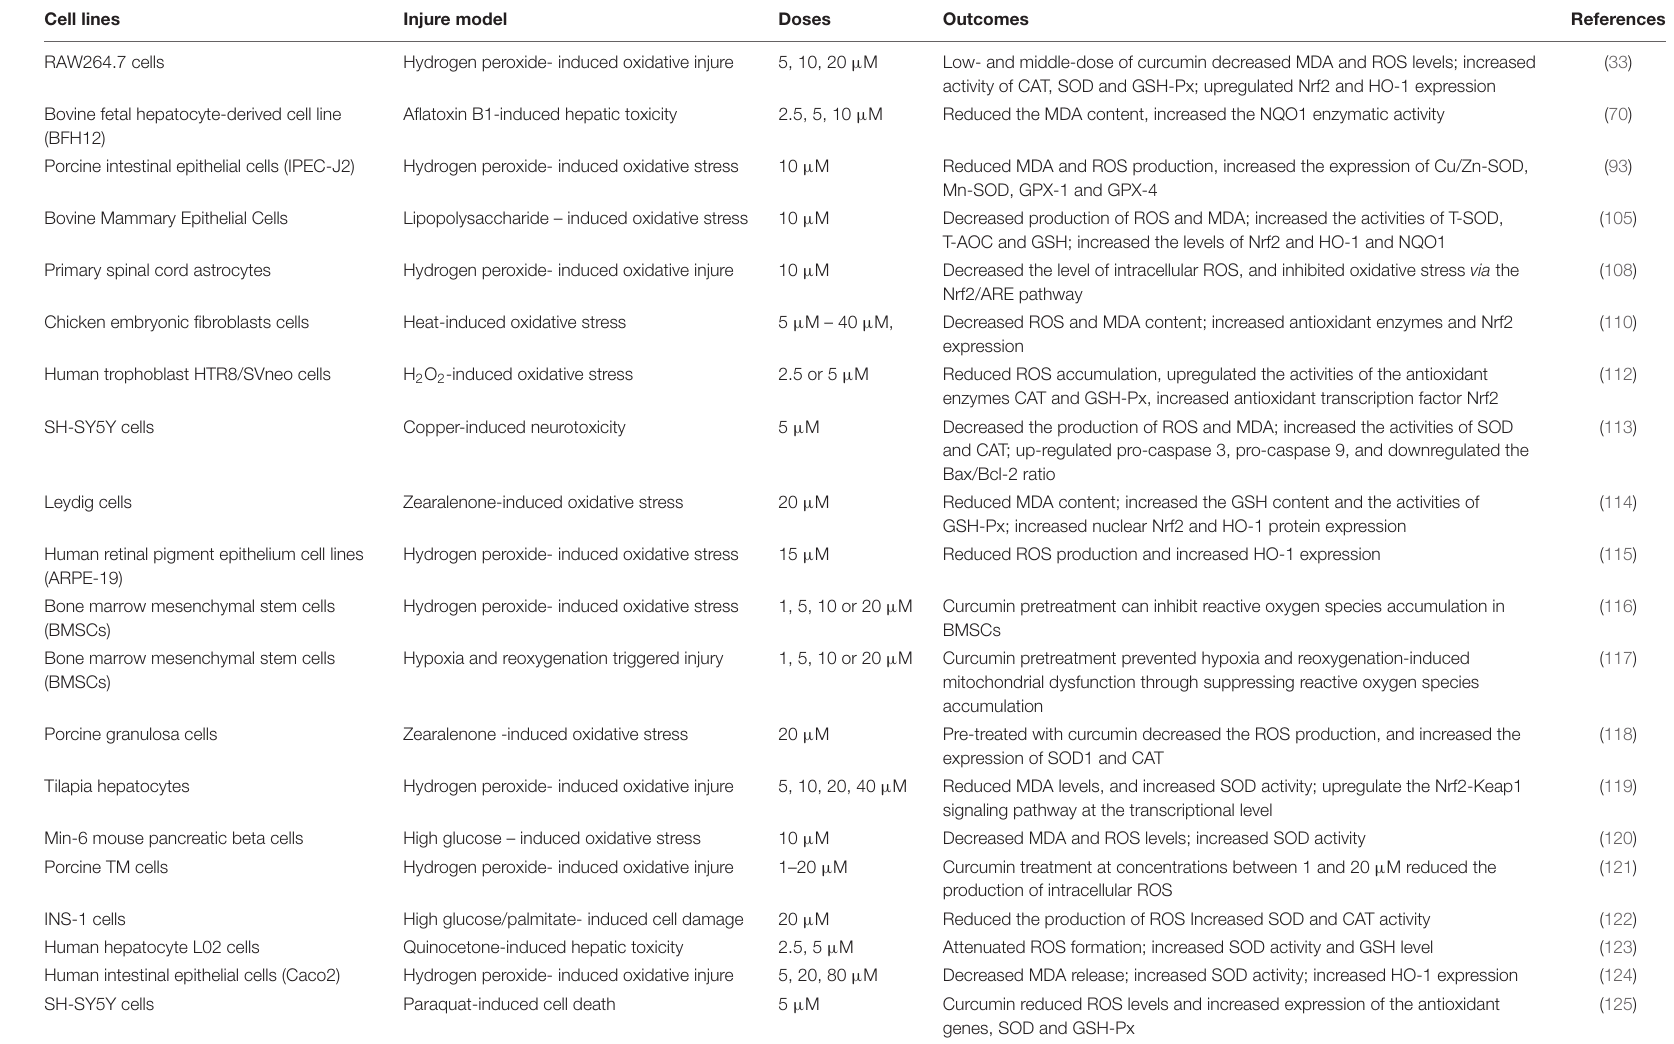
TABLE 1 | Summary of the in vitro studies investigating the antioxidant effect of curcumin. Cell